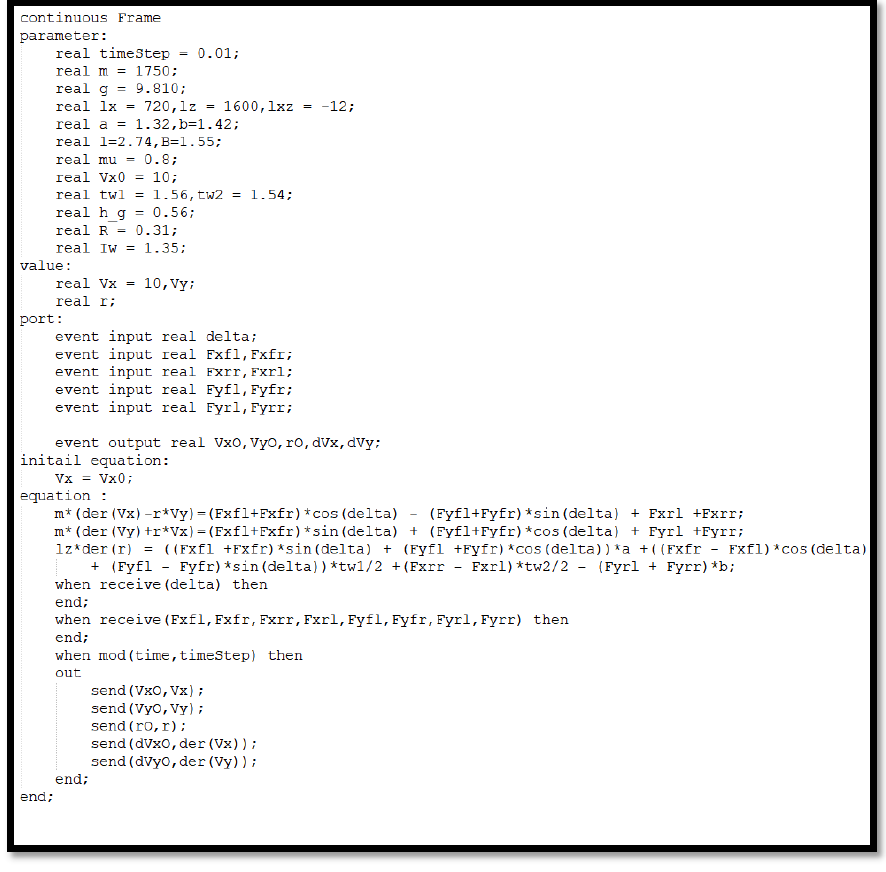
Figure 11. The Frame Model in X language.